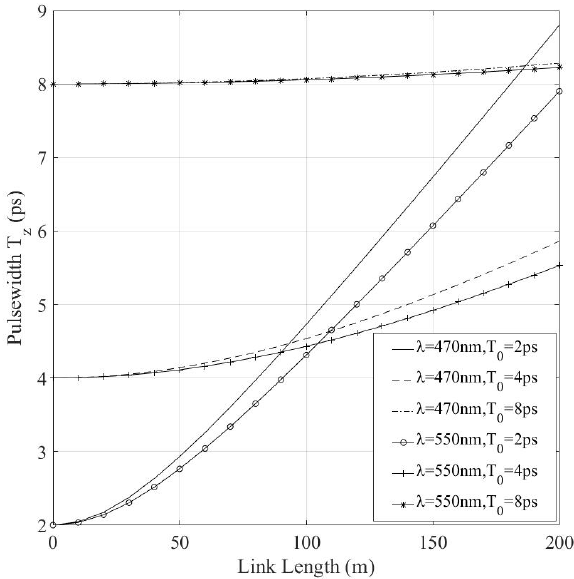
Figure 1. Pulsewidth of an unchirped pulse versus propagation distance for various wavelengths and initial pulsewidths.